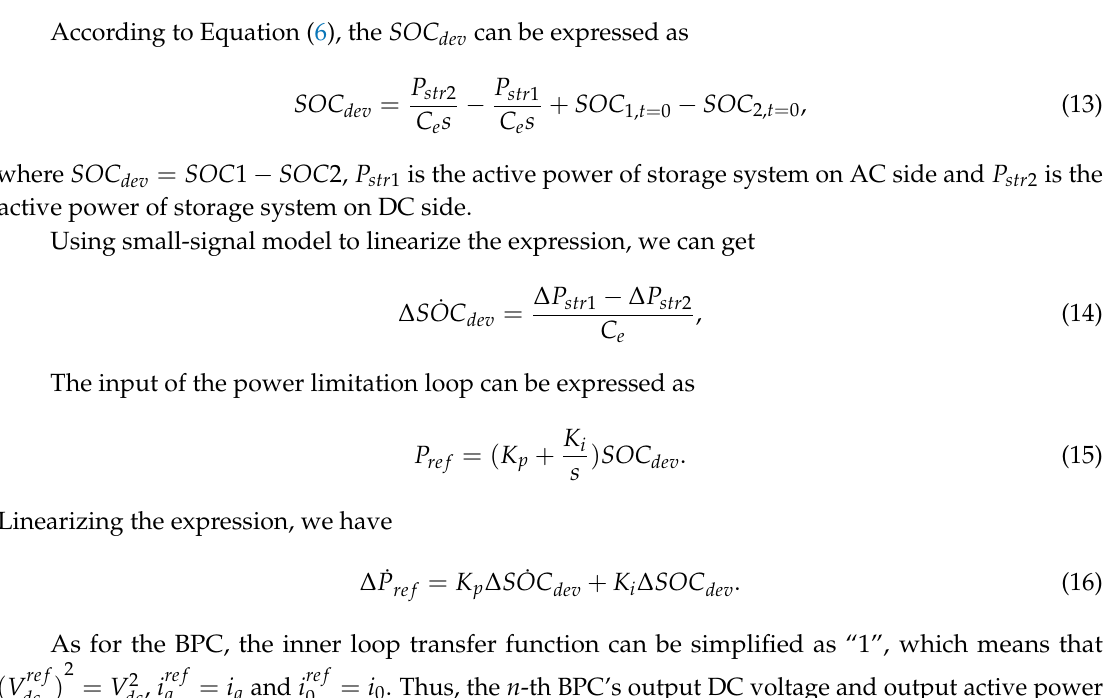
Figure 8. Simplified hybrid AC/DC